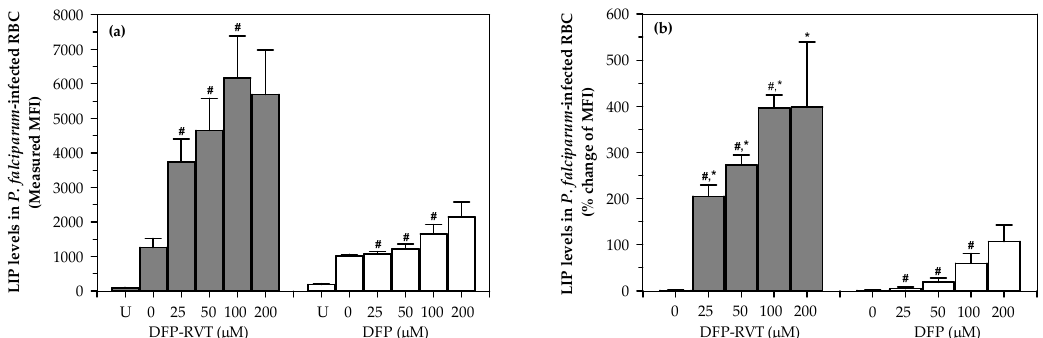
Figure 6. Intracellular LIP levels in P. falciparum (3D3 strain)-infected RBCs treated with DFP and DFP-RVT (0–200 µM each). Change in mean fluorescence intensity ( ∆ MFI) ( a ) and percentage changes of the MFI ( b ) values obtained from three independent experiments are presented as mean ± standard error of the mean (SEM) values. Statistical significance was determined using multiple t -tests, for which a p -value of <0.05 was considered significant. # p < 0.05 when compared with consecutive lower concentrations; * p < 0.05 when compared with DFP at equal concentrations.